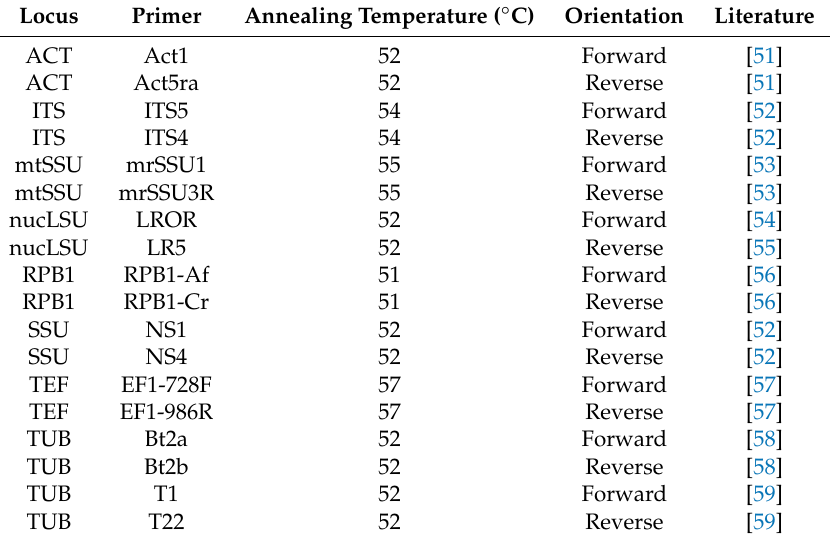
Table 1. List of primers and annealing temperatures for amplification of the target